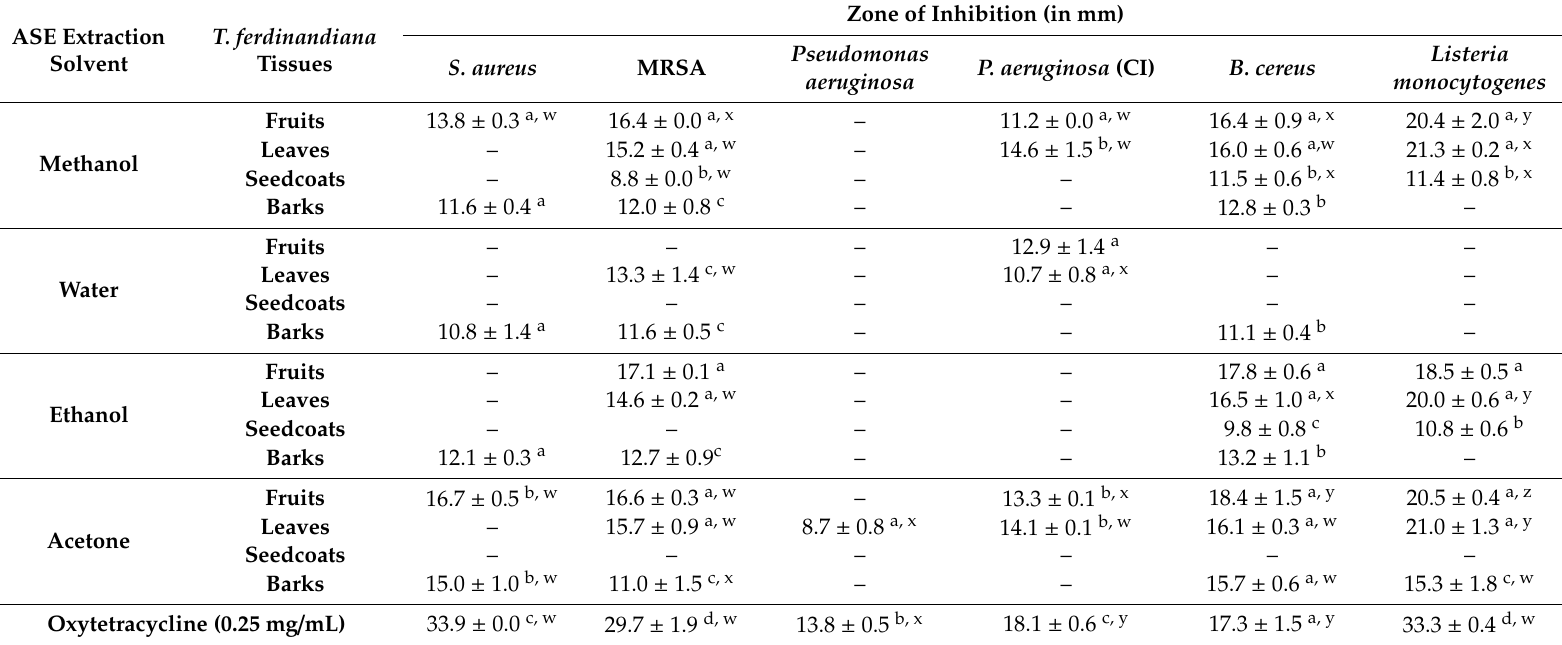
Table 5. Antimicrobial activity of the extracts of T. ferdinandiana